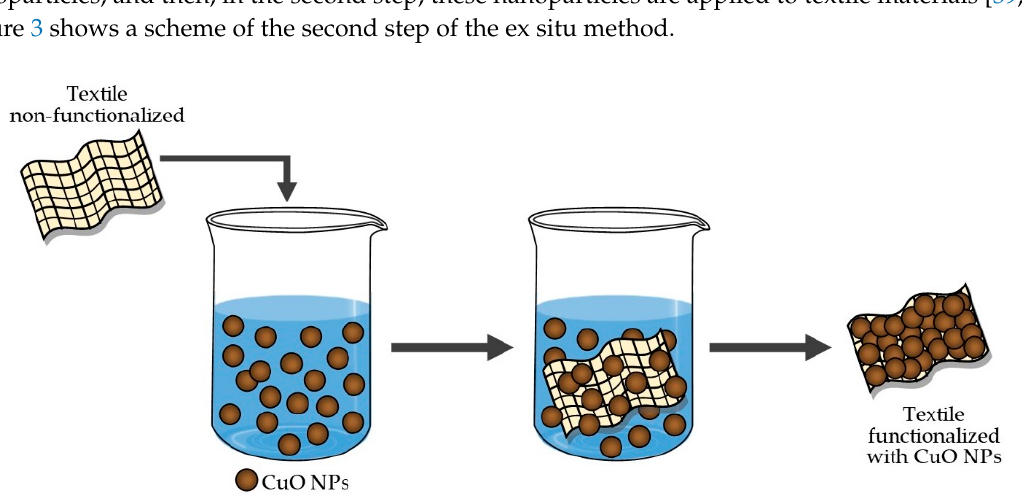
Figure 3. Scheme of the second step for textile functionalization by the ex situ method.